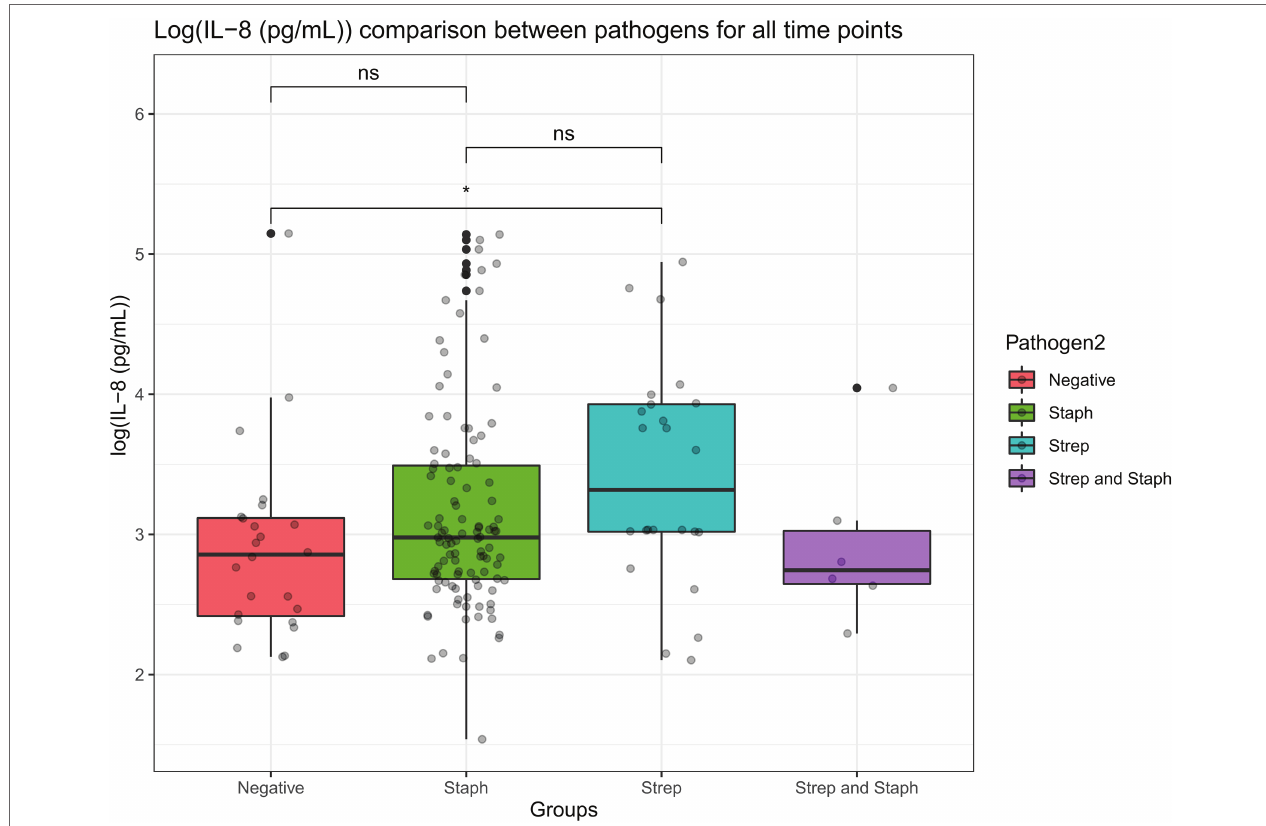
presented mastitis). Overall, the statistical tests show that there were no significant differences in IL-8 values detected in milk samples from the cows infected by each of the above-mentioned pathogens ( p > 0.05). However, there were statistical differences in IL-8 values detected in the milk samples in cows infected